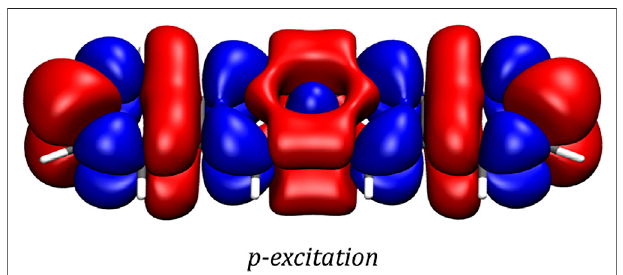
FIGURE 5 | Transition density of the p -excitation at a magnetic fi eld strength of 8,000 T as generated by a two-component CD-ev GW /BSE@ CAM-B3LYP calculation. The plot was generated with VMD using an isovalue of 0.0001 a − 3 0 . The colour blue indicates a loss while red indicates a gain of electron